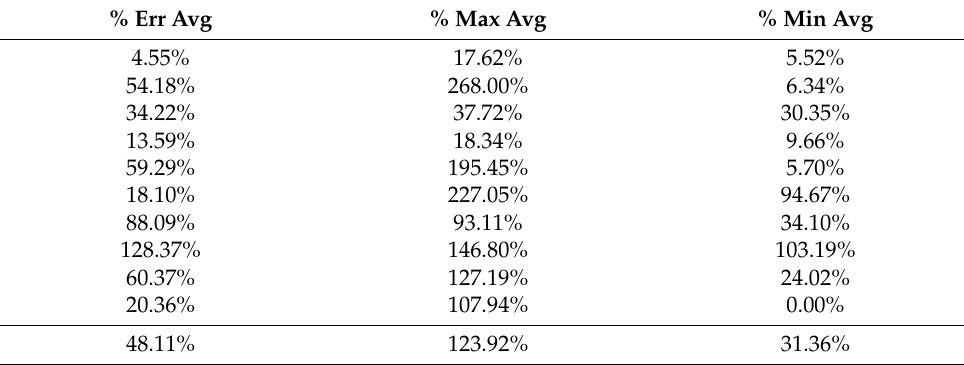
Table A210. Set 3, trials 31–40 data (actual PR